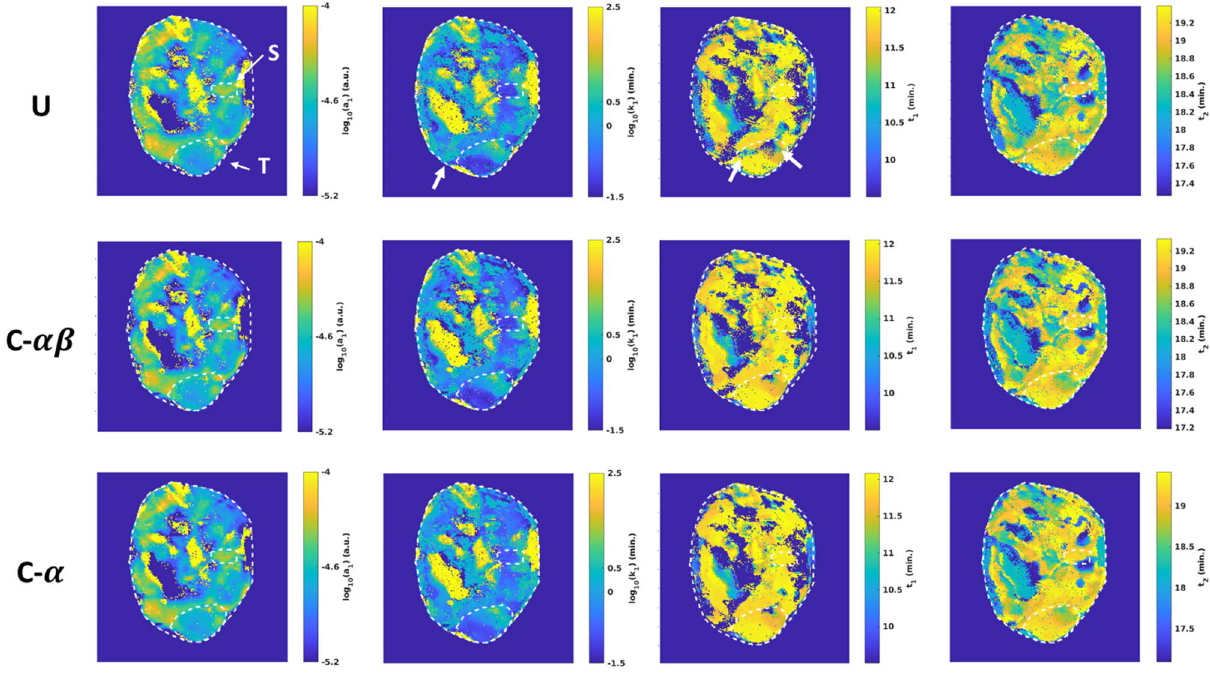
Figure 13. Selected parameters from fitting Dataset B using 7-parameter monoexponential model (Supplementary Information) using three different processing approaches. U: Unconstrained analysis. C- αβ : Constrained analysis using αβ Kalata filter. C- α : Constrained analysis using α Kalata filter. Although performance of the model fit is similar across much of the imaged area, the unconstrained analysis assigns inaccurate values of switching times to a large region on the interior of the tumor (white arrows). Figure created using a combination of MATLAB and Microsoft PowerPoint.